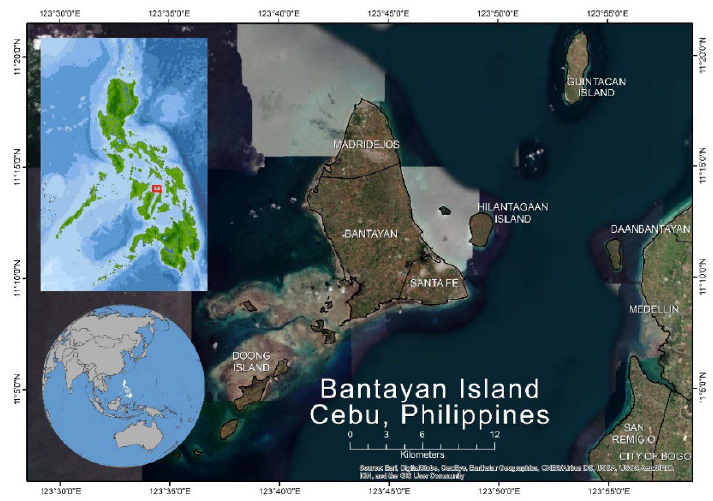
Figure 3. Satellite image: Philippines, Archipelago and Bantayan Island [15].